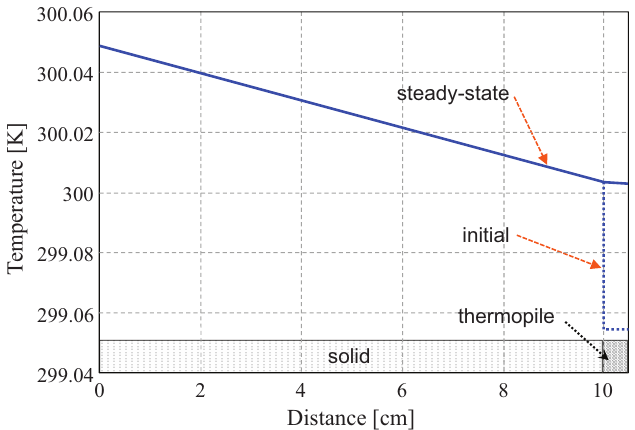
Figure 6. Temperature distribution in the 1D simulation domain at two different moments when no control is applied. The heat flux injected at the left of the structure is 0.1 W/m 2 . The initial temperature difference between the thermopile and the surface is 0.05 K. Steady-state is reached when the temperature distribution at the solid-thermopile interface is almost